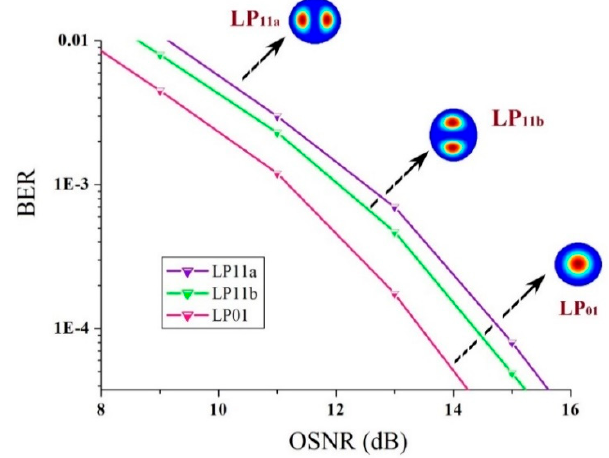
Figure 21. The BER vs. OSNR for three different modes for a PDM-QPSK signal using the STBC-RLS scheme [27].